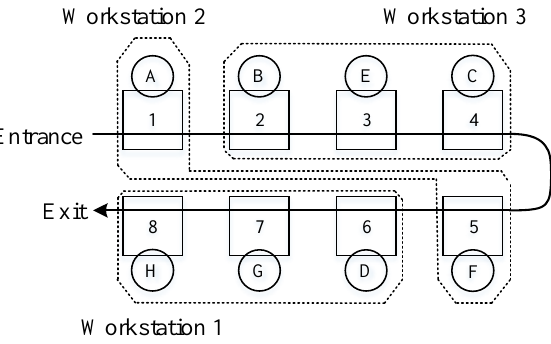
Figure 6. An illustration of long walking distance.